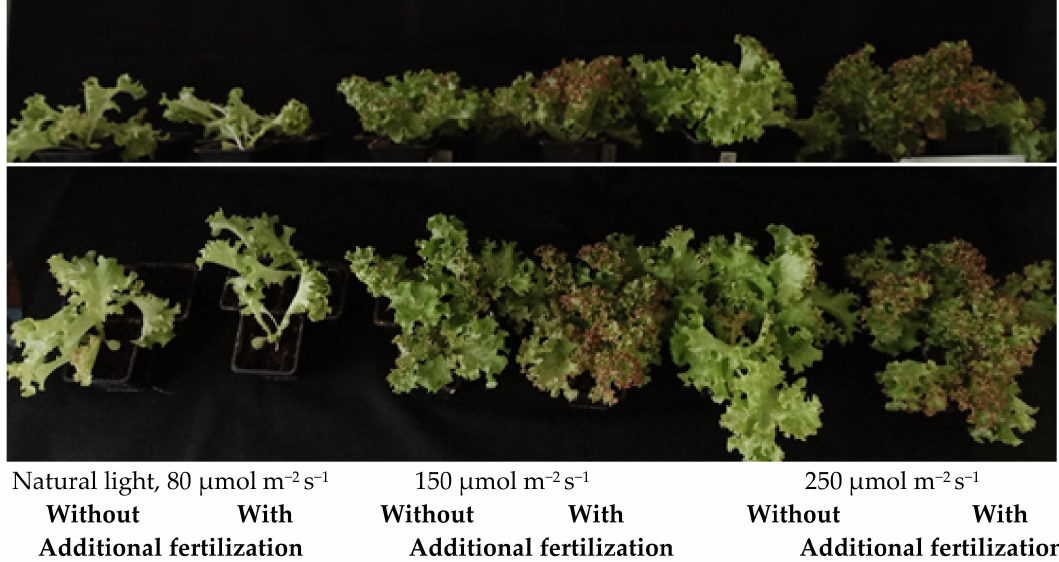
Figure 2. Light intensity and fertilization effect on lettuce growth. Natural light corresponds to 4.6 mol m − 2 d − 1 ; 150 µ mol m − 2 s − 1 corresponds to 8.6 mol m − 2 d − 1 ; 250 µ mol m − 2 s − 1 corresponds to 14.4 mol m − 2 d − 1